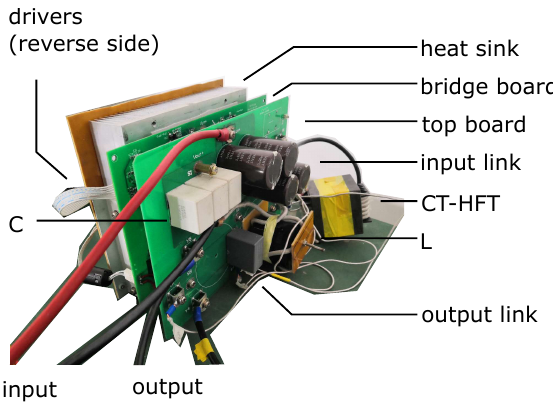
Figure 12. Experimental